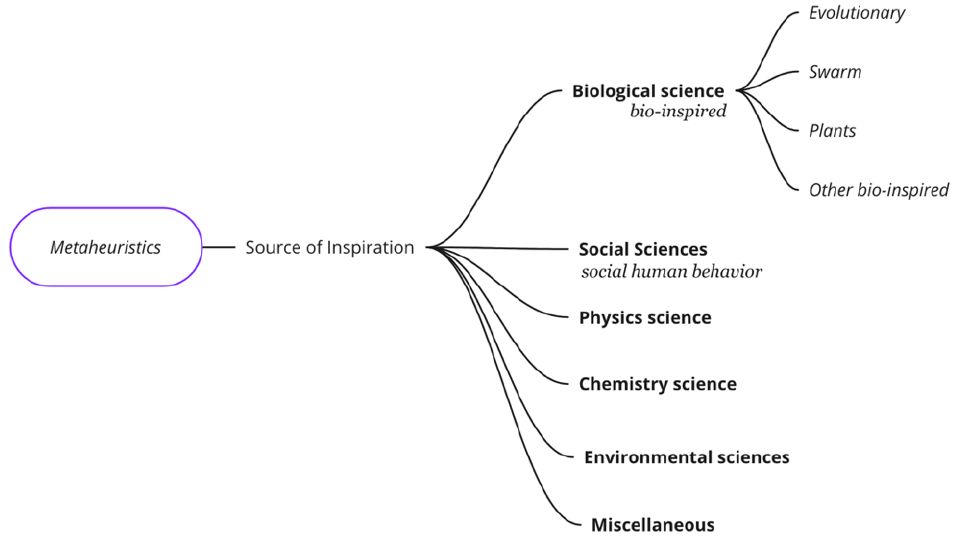
Figure 4. Families of metaheuristics by source inspiration or metaphor used.